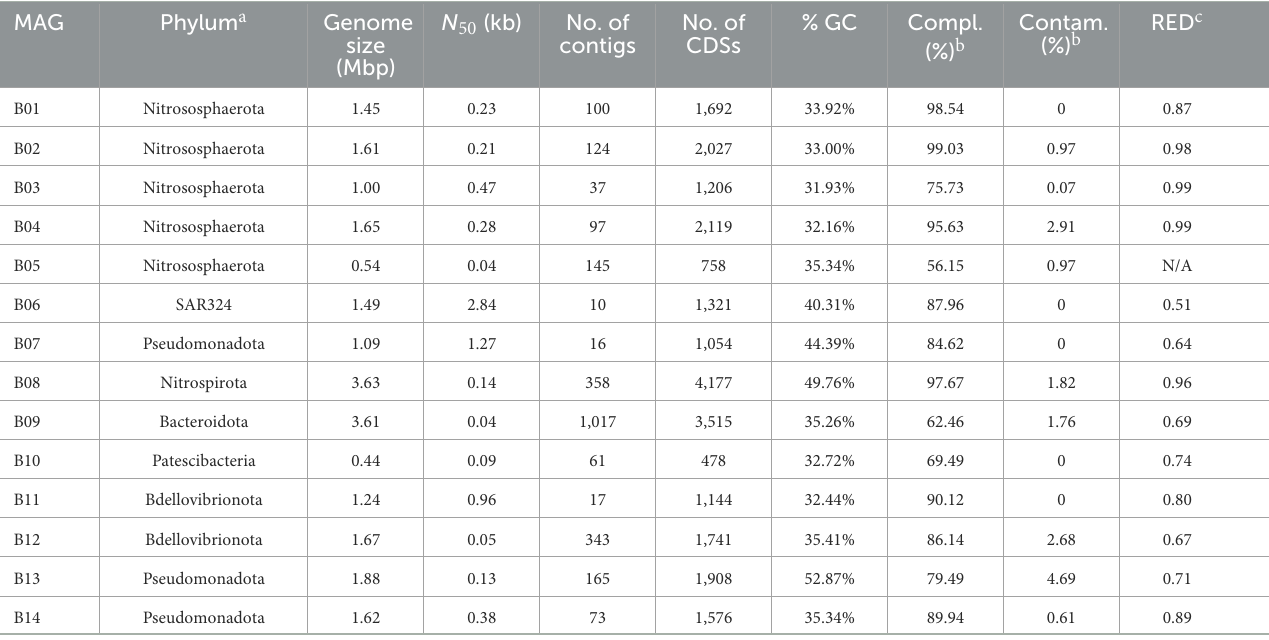
TABLE 1 General genomic features of the 14 sponge-associated prokaryotic MAGs.